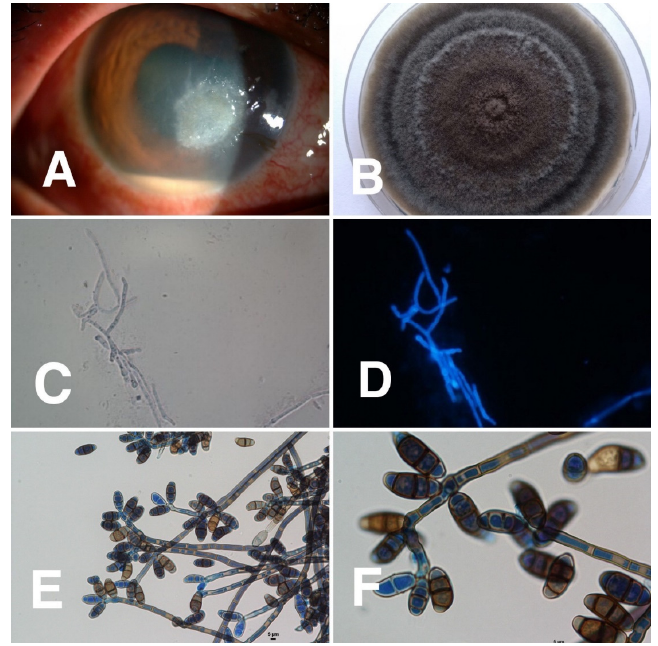
Figure 5. Clinical characteristics of Curvularia keratitis and microbiological identification from corneal scraping specimens. ( A ) Curvularia keratitis showing a raised lesion, feathery edge, and macroscopic central pigmentation; ( B ) cultivation on Sabouraud’s dextrose agar at 28 °C shows black velvety colony; ( C ) 10% KOH mount showing fungal hyphae, magnification 400; ( D ) fluorescent microscopic picture was taken after calcofluor white staining, magnification 400; ( E , F ) microscopic examination of the slide culture shows curved macroconidia with central enlargement, at 100 and 400 magnifications.